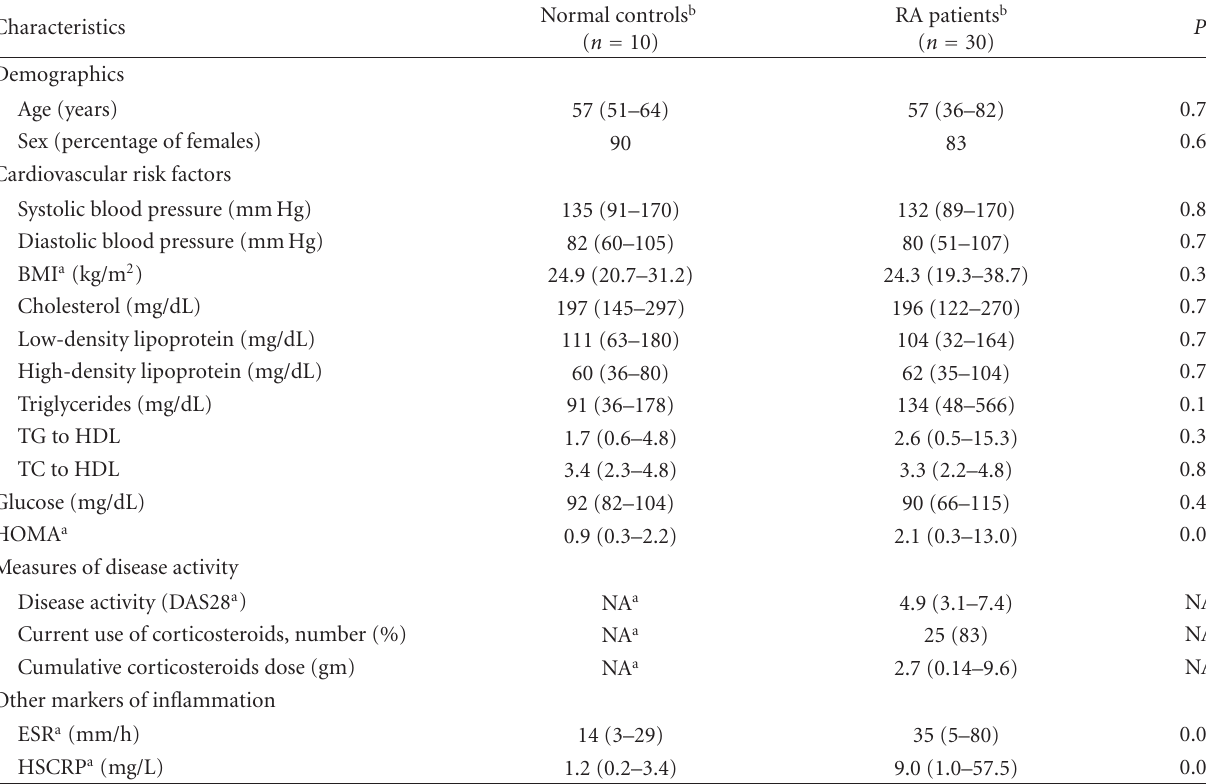
Table 1: Demographic and clinical characteristics of normal controls and RA patients.